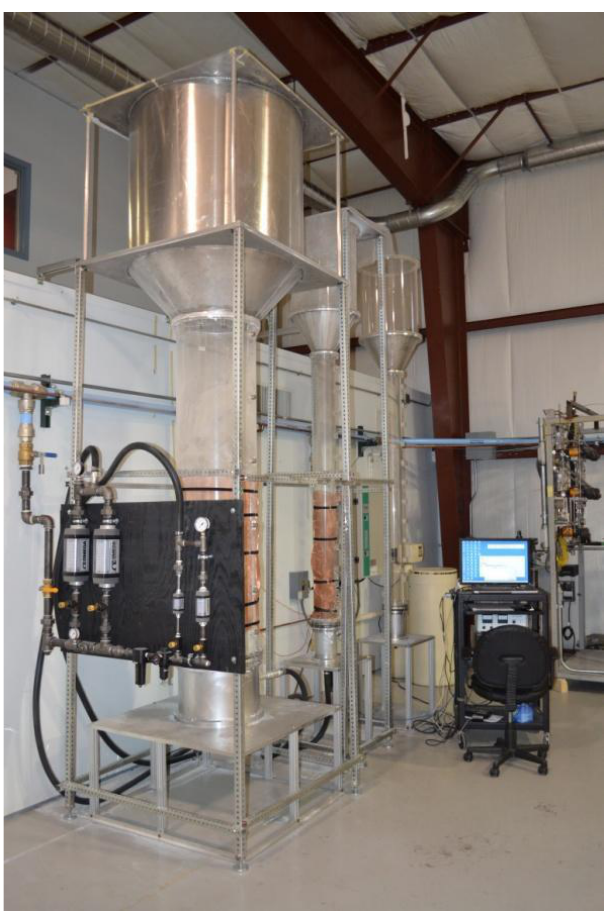
Figure 3. Photo of the two fluidized beds set-up along with the air flow system used in this work.